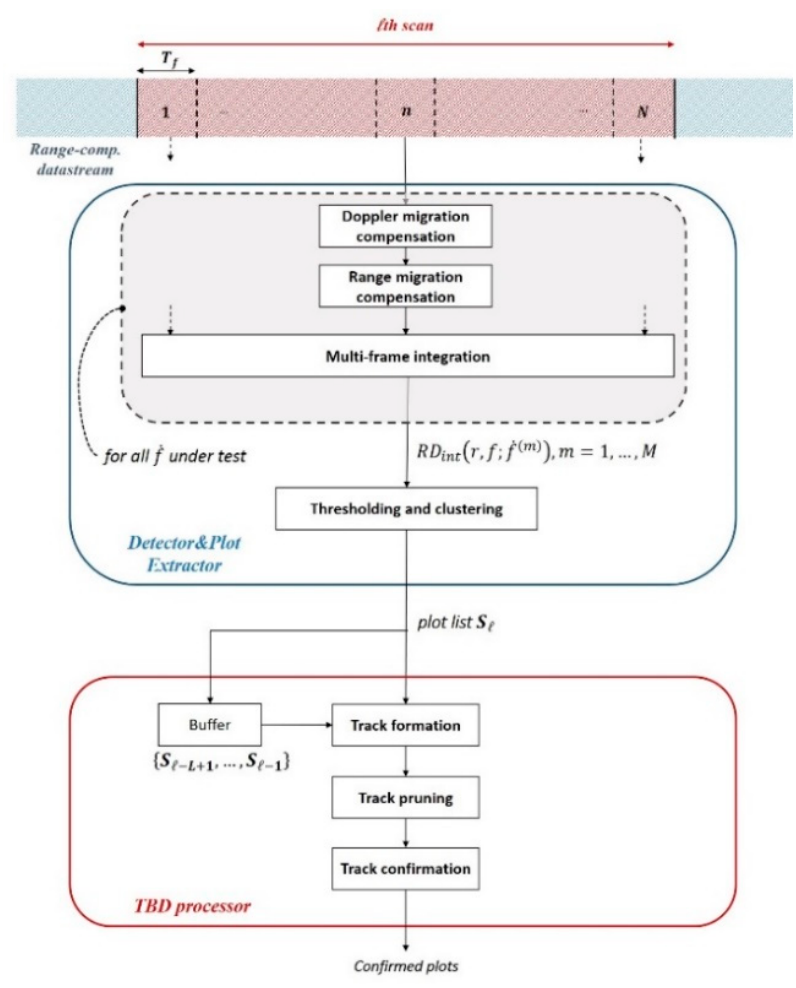
Figure 4. Detection scheme.